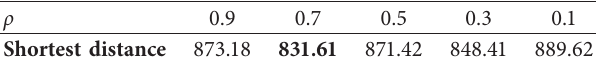
Figure 9: Effect of different pheromone volatility coefficients on the path of ant colony optimization RRT algorithm ( ρ is pheromone Table 4: Influence of different pheromone volatility coefficients on Table 5: Influence of different ant numbers on algorithm results. algorithm results.